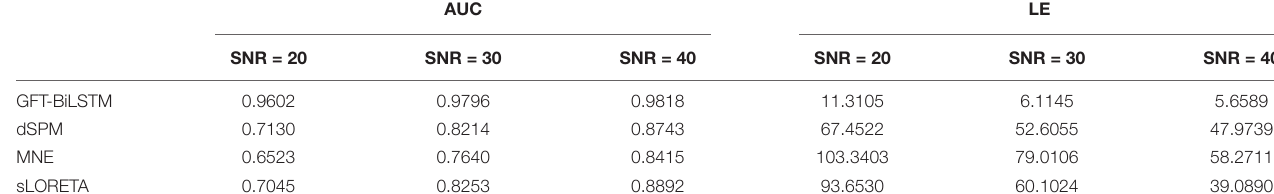
TABLE 2 | The evaluation metrics corresponding to different ESI inverse solutions with multiple activated areas.